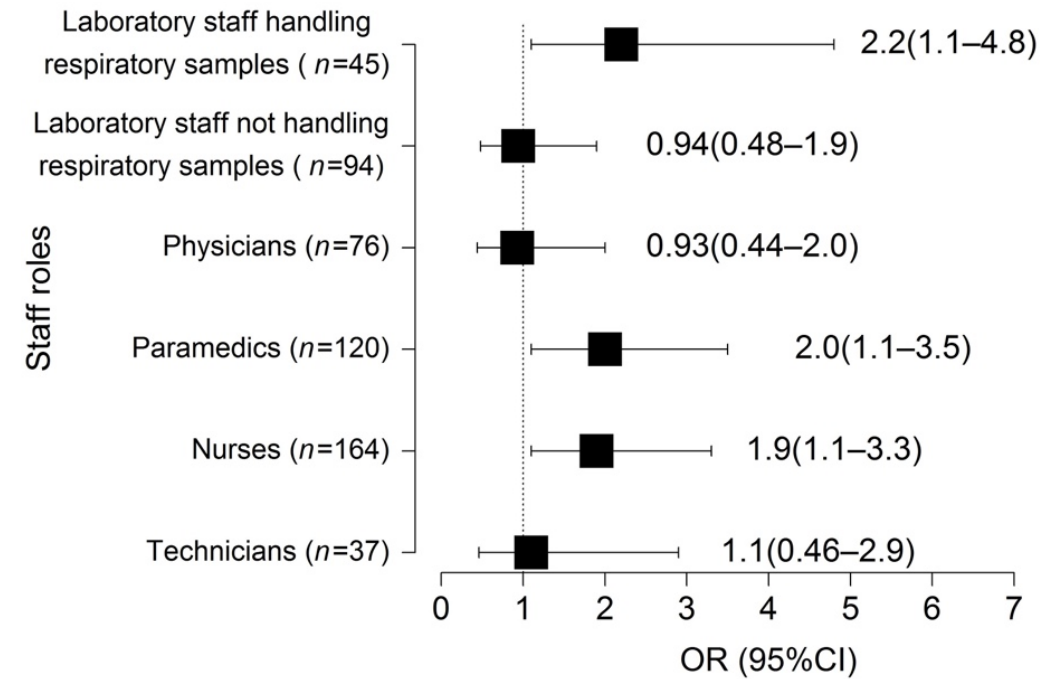
Figure 3. Impact of the healthcare workers (HCWs) staff role on the risk of developing SARS-CoV-2 infection (at least one RT-PCR positive result). Odds ratio and 95% confidence intervals calculated by logistic regression when compared to control non-patients facing group (administrative staff and research scientists). Table 3. Impact of the demographic characteristics and healthcare workers (HCWs) staff role on the risk of presenting at least one reverse transcriptase-polymerase chain reaction (RT-PCR) positive result. Adjusted odds ratio and 95% confidence intervals calculated by logistic regression when compared to control non-patients facing group (administrative staff and research scientists).